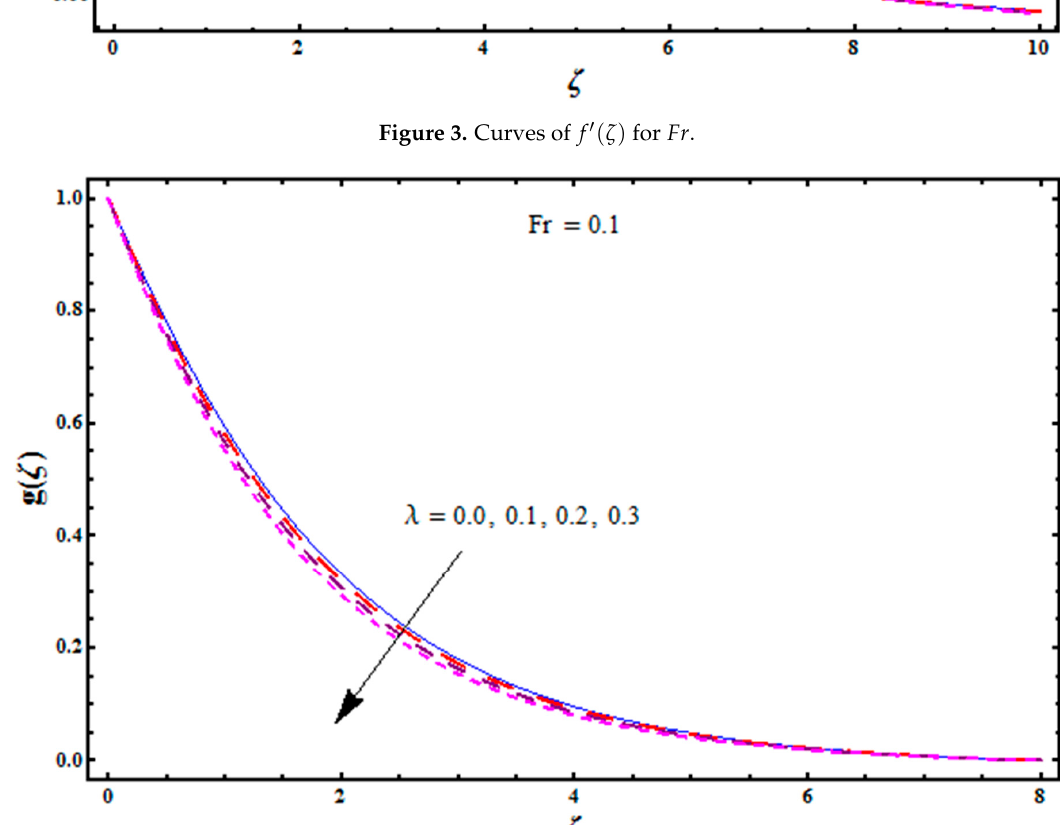
Figure 4. Curves of g ( ζ ) for λ